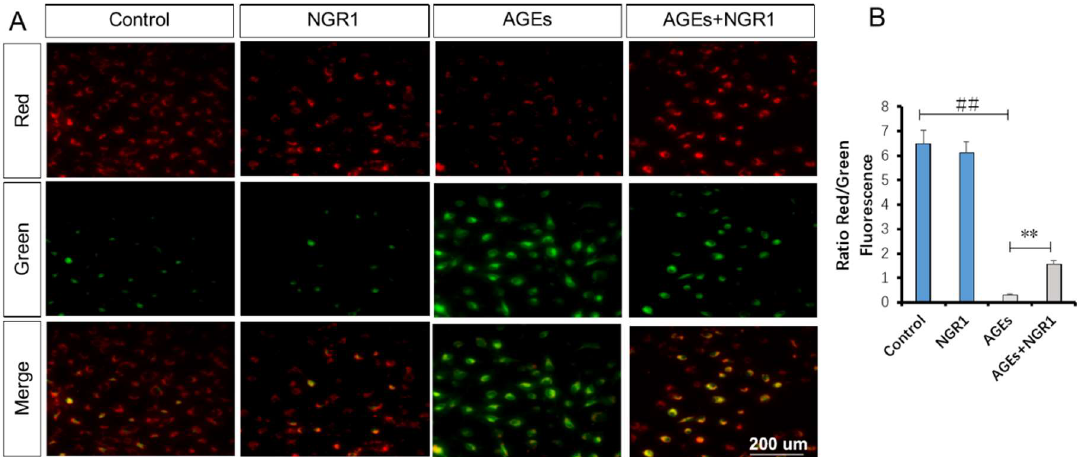
Figure 8. NGR1 inhibited AGE-induced mitochondrial transmembrane potential (MTP) reduction in HK-2 cells. ( A , B ) Representative images and quantitative analysis of JC-1 staining. Treating HK-2 cells with AGEs caused a significant decrease in the ratio of red to green fluorescence intensity, which is a sign of the early stages of cell apoptosis. The bar represents 200 µ m. All data are presented as the mean ± SD ( n = 10 wells per group). ## p < 0.01 vs. the control group; * p < 0.05 vs. the AGE